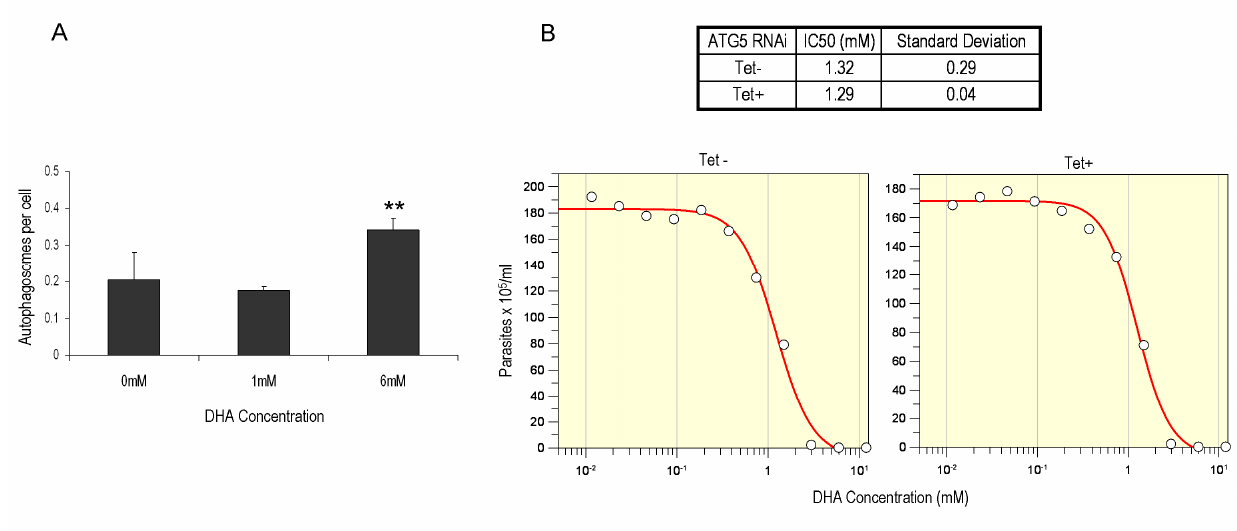
FIGURE 4: Autophagy is not required for dihydroxyacetone (DHA) induced bloodstream form cell death. (A) DHA increases autophagosome numbers in BSF 2T1 cells. BSF 2T1 cells expressing YFP-ATG8.2 were grown with 1 mM and 6 mM DHA for 20 h. The mean number of au- tophagosomes per cell was determined by counting >200 cells with data displayed as a mean of three replicate experiments and error bars represent standard deviation and asterisks indicate where data differed significantly from the mean of the untreated controls **p<0.001. (B) The IC 50 of DHA was determined for BSF 2T1 YFP-ATG8.2 following 48 h ATG5 RNAi induction (tet+) and un-induced control cells (tet-). Para- sites were cultured with serially diluted DHA for 48 h before determining cell density. Graphs are representative of three replicate experi-